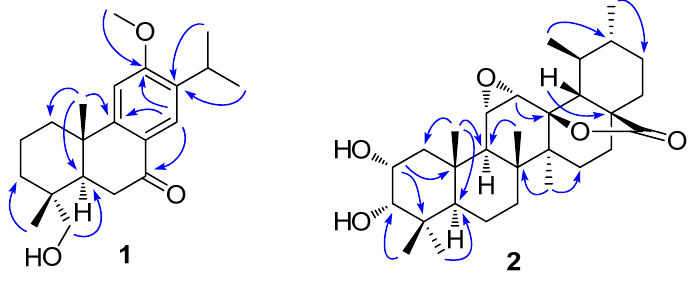
Figure 3. Key HMBC correlations (H → C) of compounds 1 and 2 .